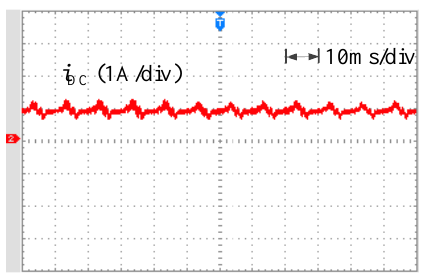
Figure 23. The DC side current i DC with PR control plus I avg control loop ( I avg * = 1 A).